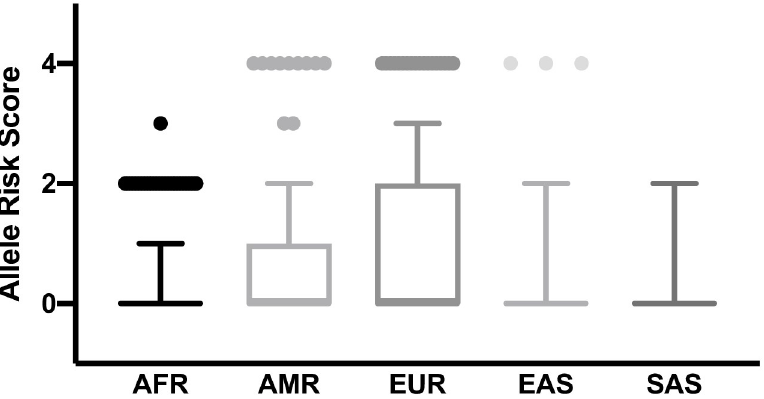
Fig 7. Distribution of the number of risk alleles for haemochromatosis among global populations. Designation of the risk allele was determined by previously published information as presented in S1 and S2 Tables. AFR, African; EUR, European; AMR, American; EAS, East Asian; SAS, South